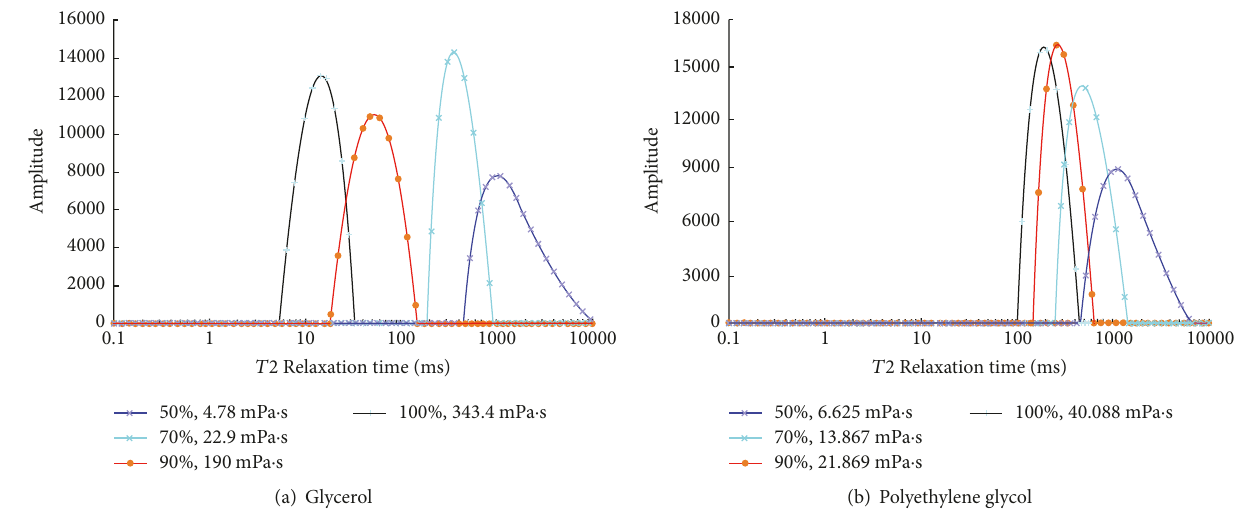
Figure 4: 𝑇 2 spectra of solutions at different concentrations.